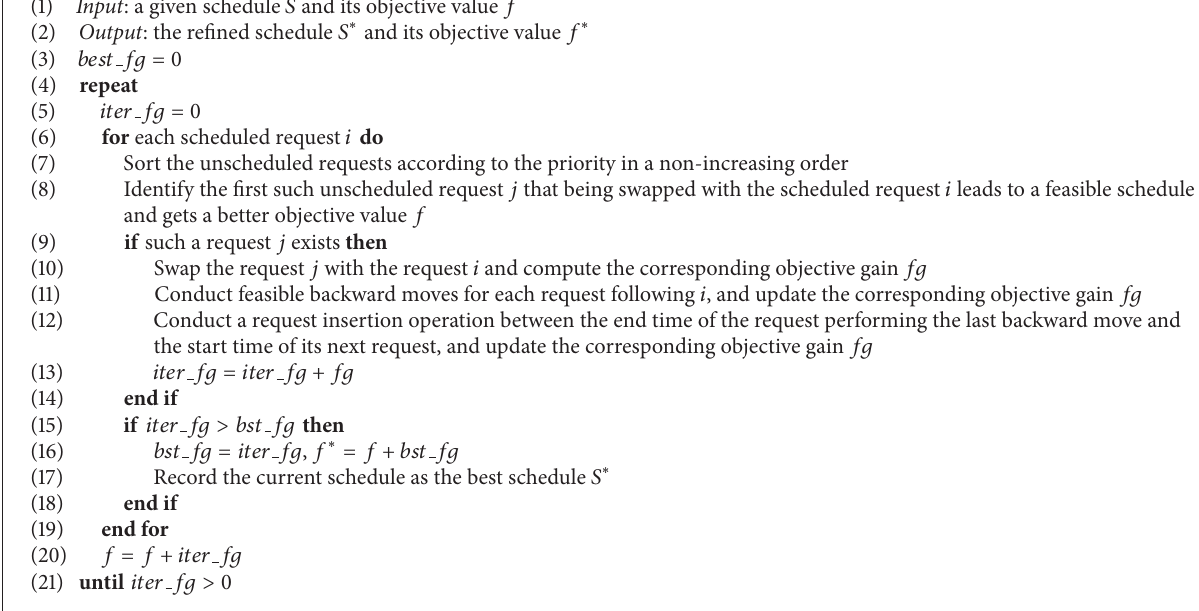
Algorithm 3: Pseudocode of the Simple Insertion Improvement Heuristic.